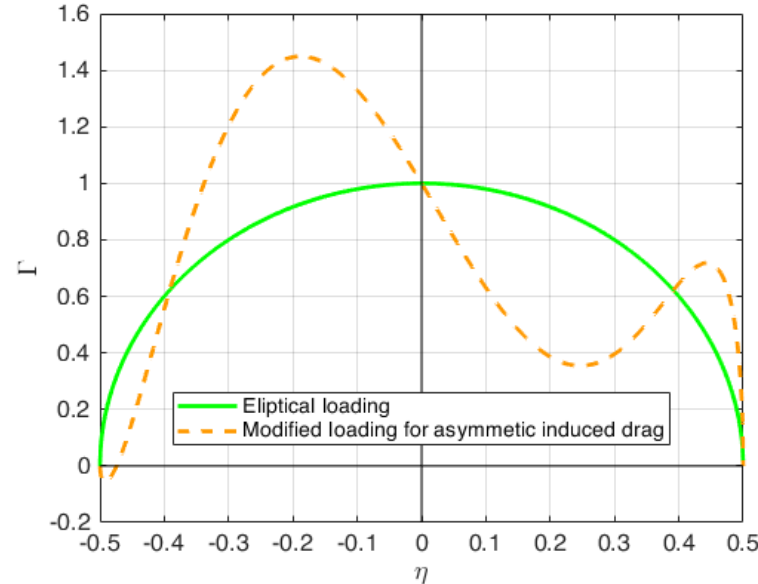
Figure 1. Two different load distributions that produce the same lift and no rolling moment but different levels of induced drag. Solid line, symmetric elliptical loading; dashed line, equivalent distribution tailored to produce a net yawing moment through laterally asymmetric induced